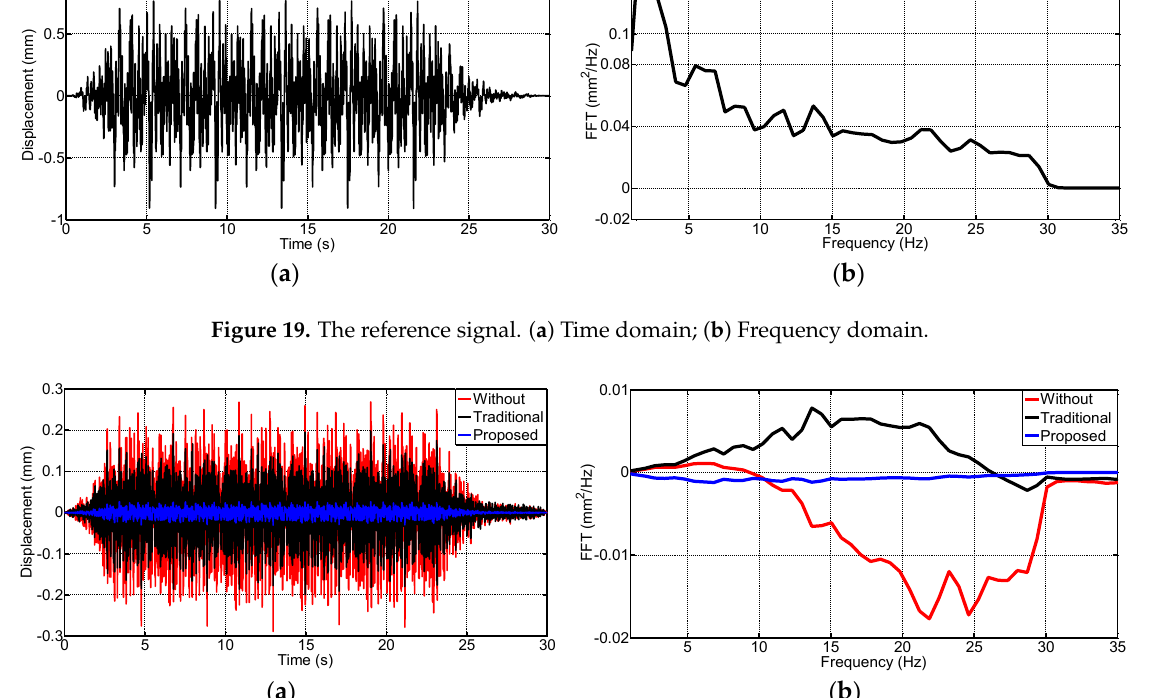
Figure 20. Synchronization errors under random signal. ( a ) Time domain; ( b ) Frequency domain. Table 5. Synchronization errors under random signal.